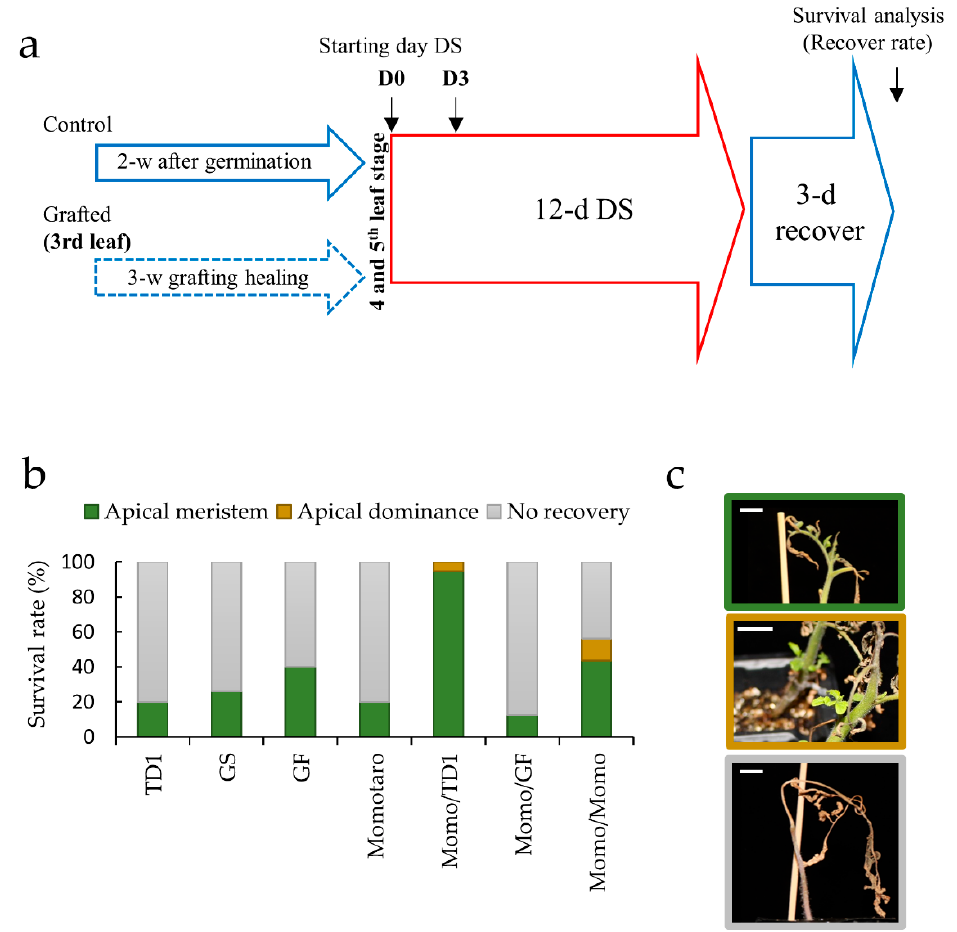
Figure 1. Grafting in tomato plants increases survival rate through the shoot apical meristem and apical dominance recovery from the axillary bud. ( a ) Schematic representation of the drought stress experimental design, marking the points of sample collection for RNA sequencing. D0 indicated before treatment and D3 indicates 3 d of drought stress treatment. GH = grafting healing, DS = drought stress. ( b ) Survival rates of all tomato lines after drought stress treatment. ( c ) Phenotype of self-grafted Momotaro (Momo/Momo) tomato recovery after 12 d of drought stress treatment through apical meristem, apical dominance, or no recovery. Control: TTM-079 [TD1 ( n = 30)], green guard [GS ( n = 30)], green force [GF ( n = 30)], and Momo ( n = 30). Grafted: Momo/TD1 ( n = 19), Momo/GF ( n = 8), and Momo/Momo ( n = 16). Green = apical meristem, brown = apical dominance, and gray = no recovery. White scale = 1 cm.